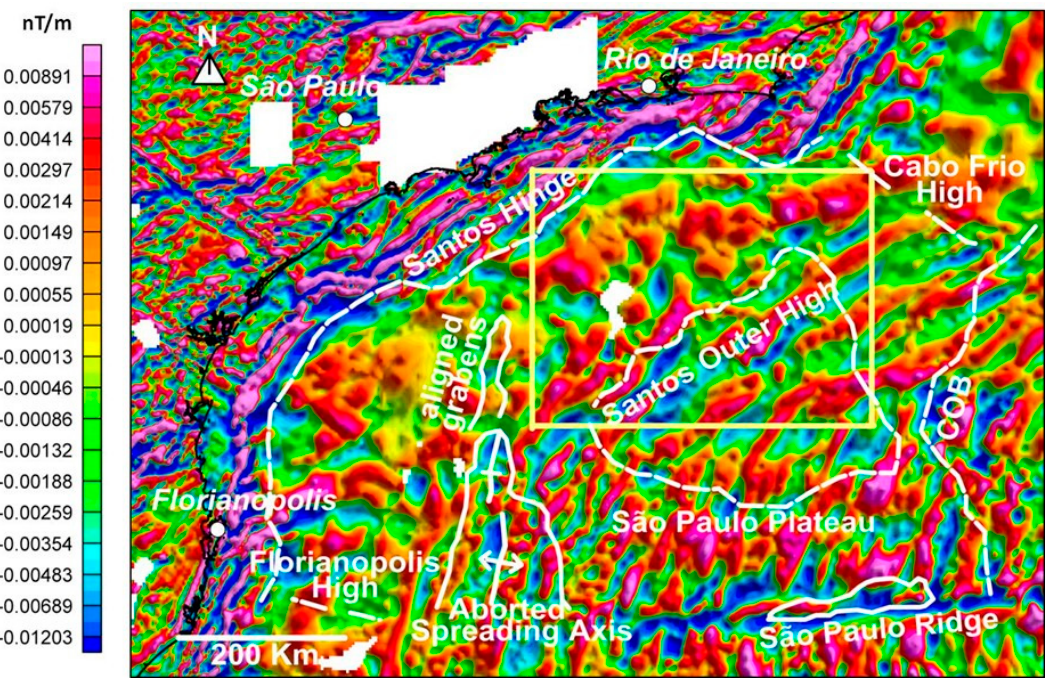
Figure 5. Vertical gradient of the total magnetic field map. The blue areas correspond to the minimum gradients, whereas the red and pink correspond to the maximum gradient areas. The yellow rectangle corresponds to the area studied in detail. COB corresponds to the continent–ocean boundary.